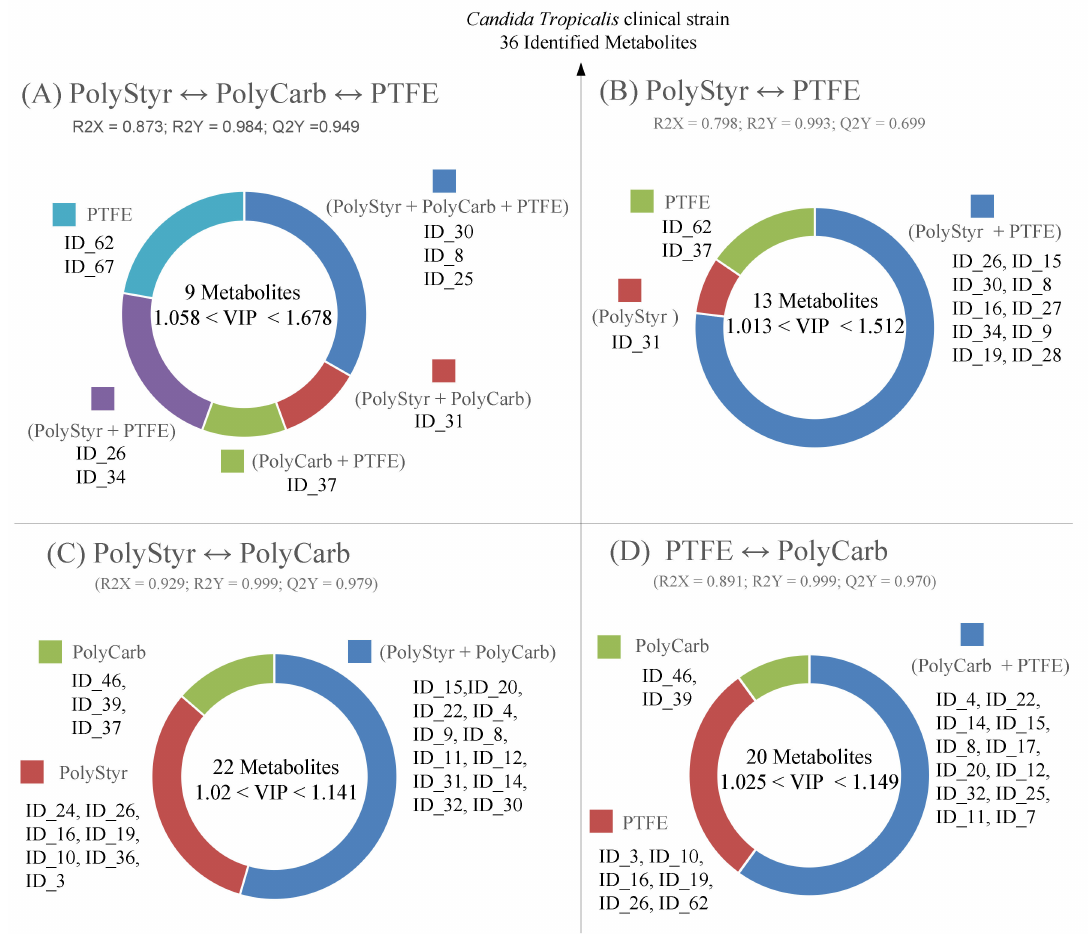
Figure 5. Visual presentation of results of interclasses PLS-DA analyses ( A – D ). Only the set of metabolites with VIP scores > 1, which significantly contributes to the PLS-DA models, is presented. PLS-DA models have been validated by the statistics R2X, R2Y, and Q2Y (from five-fold cross validation), whose values are reported for each model in the figure. Metabolites can be tracked back to identified metabolites in Table 1 through the ID_##